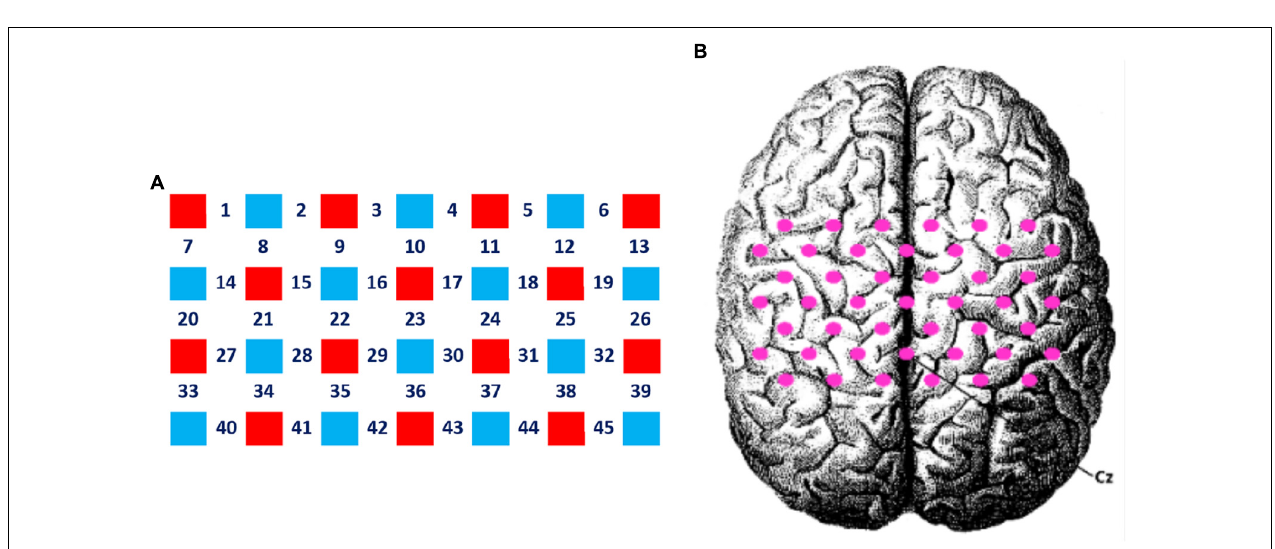
FIGURE 1 | Flow chart of the experimental paradigm. The experimental paradigm was divided into three tasks of motor execution, action observation, and motor imagery. The sequence of the tasks was randomized. A visual cue for 2 s was presented in the middle of the monitor as a signal to progress to the next task.